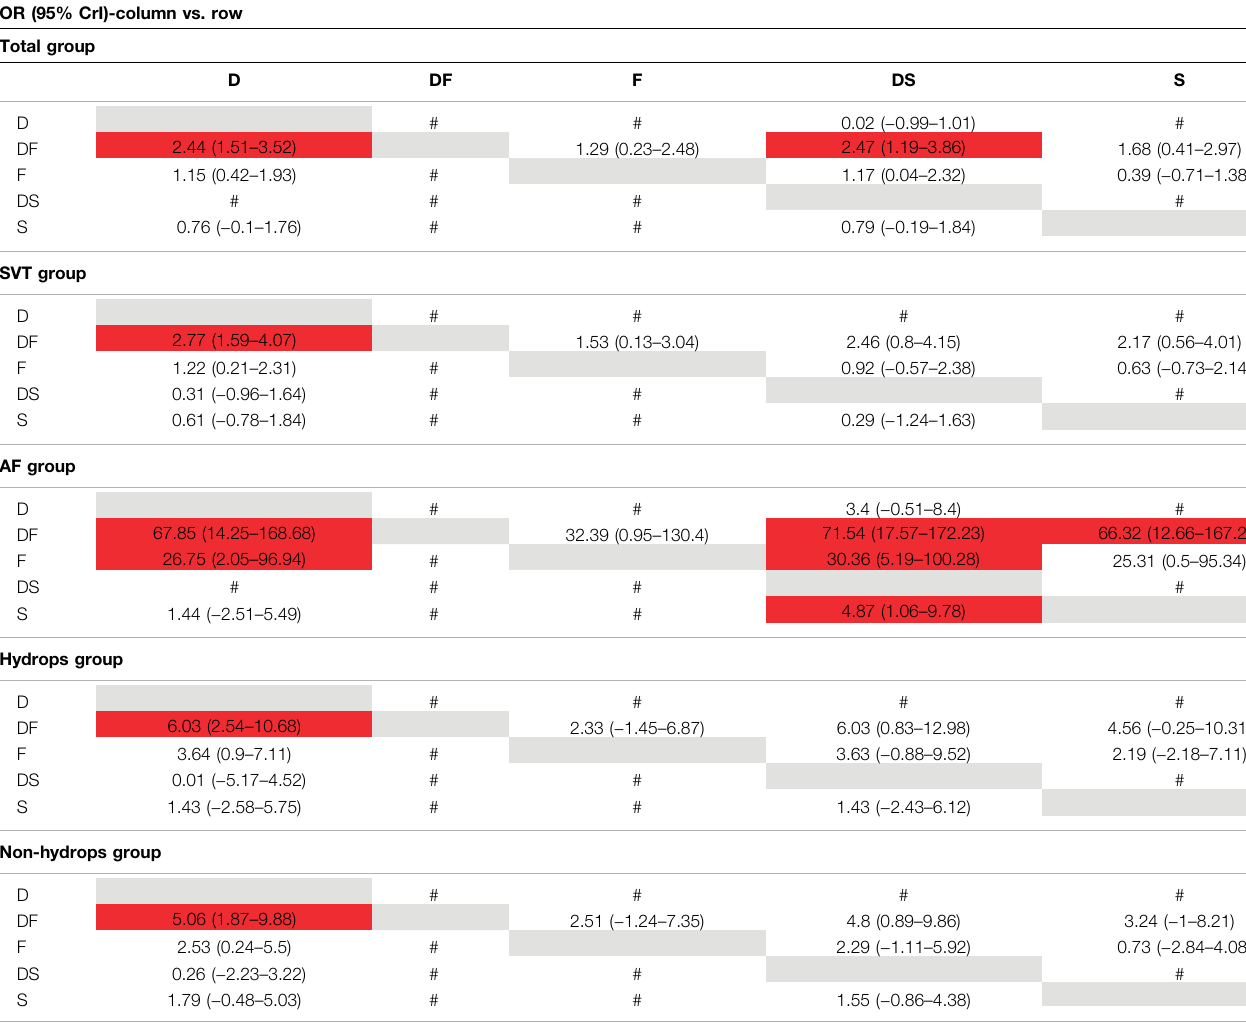
TABLE 1 | OR (95% Cl) data from the total, SVT, AF, hydrops, and non-hydrops groups. OR (95% CrI)-column vs.